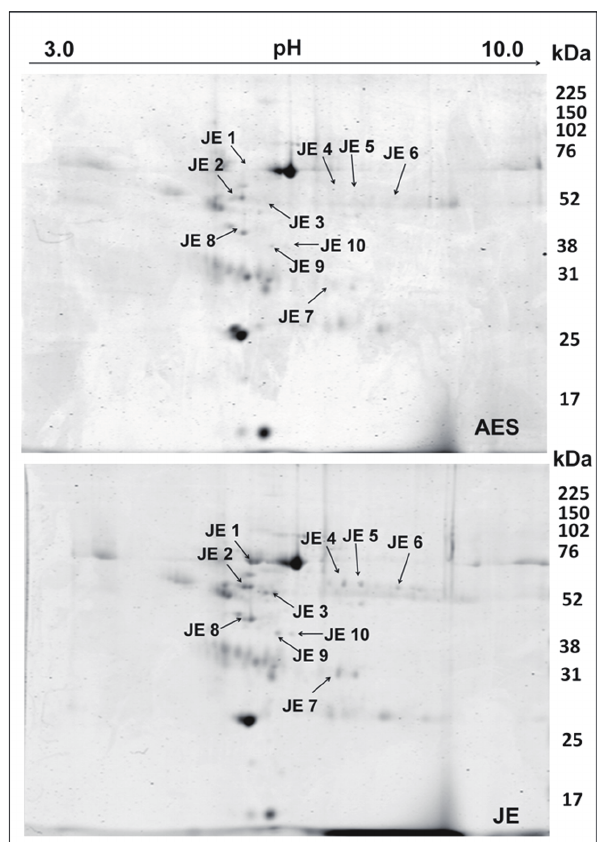
Figure 1. Comparative proteomic analysis of cerebrospinal fluid from AES and JEV patients. Cerebrospinal fluid samples were pooled and proteins were extracted and separated on immobilized linear pH gradient IPG strips (pH 3.0–10.0) and then in the second dimension on 12% SDS-PAGE. Spots exclusively visualized in the JE- CSF were marked and excised, and identified by MALDITOF/MS and database searches. The spots are labeled on the gel according to the numbers presented in Table 2. Images are representative of 4 replicate